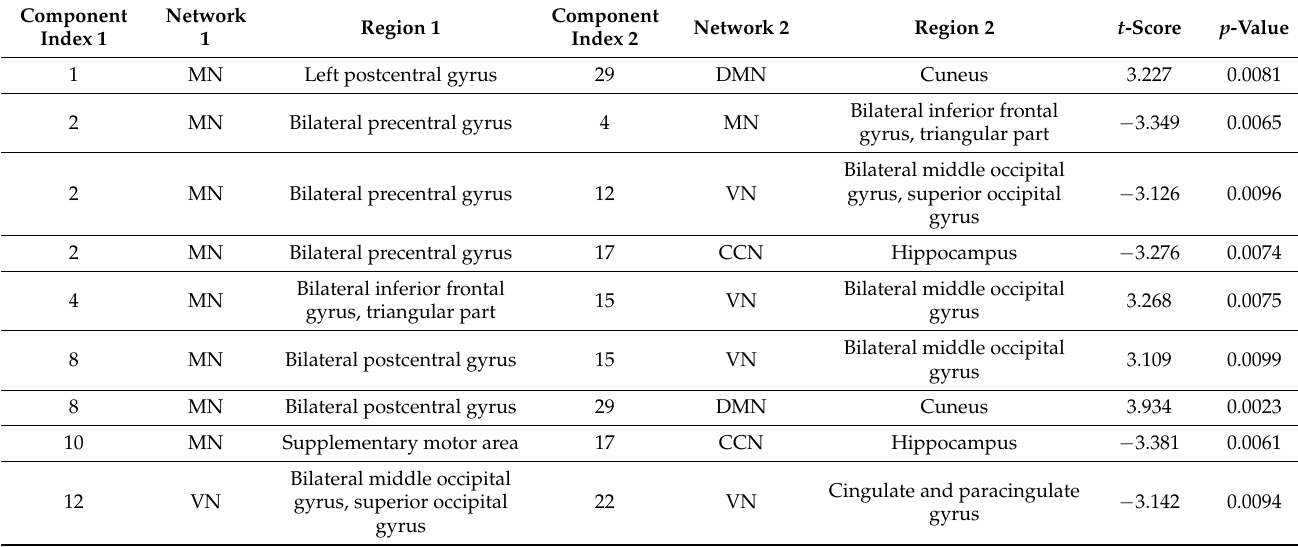
Table 1. Statistics and specific brain locations of connections that survived the NBS approach in state 2 of the experimental group for the post-training run versus the pre-training run.